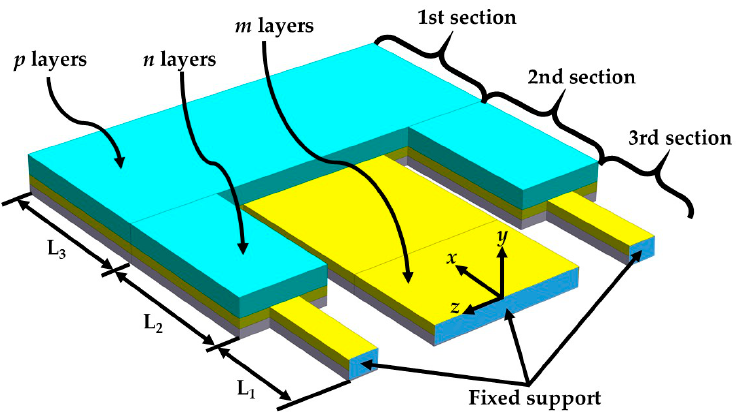
Figure 4. Schematic of the pVEH microdevice equivalent resonator, which is divided in three different cross-sections.